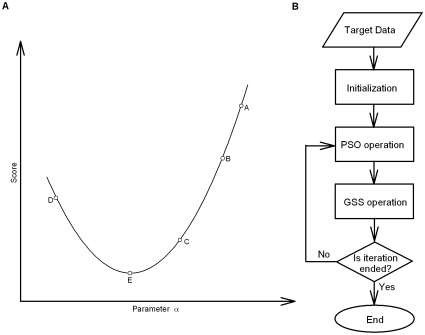
Schematic diagram for GSS and PSO.(A) A schematic drawing for golden section search algorithm (GSS). (B) A flow graph for the PSO-GSS algorithm.